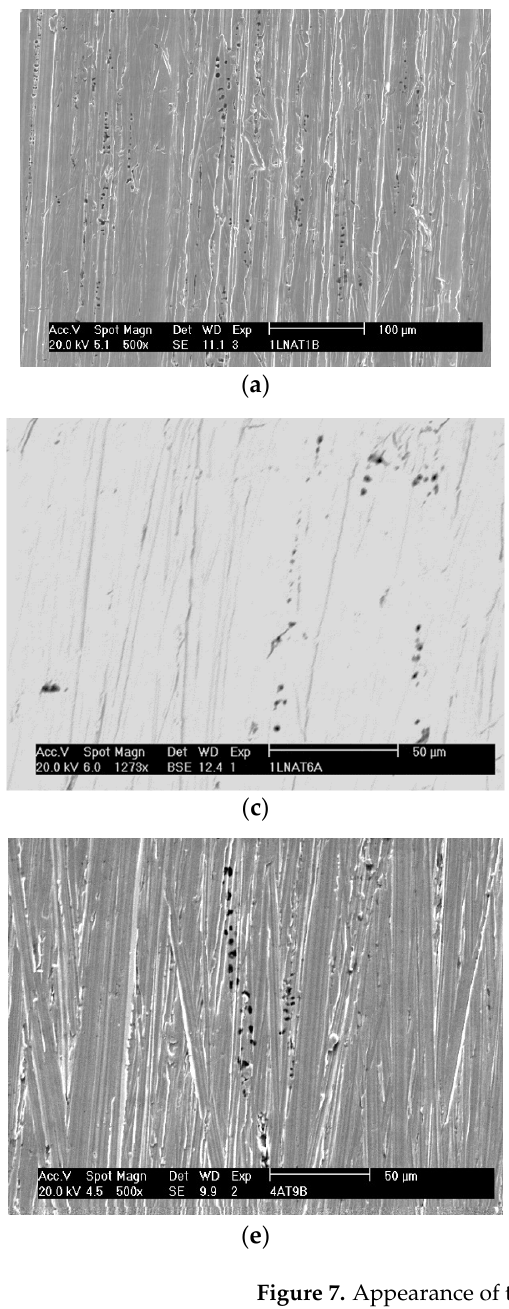
Figure 7. Appearance of the pits obtained by SEM after the corrosion test for the samples: A0 with secondary electrons at a magnification of ×500 ( a ), A1 with secondary electrons at a magnification of ×200 ( b ), A2 with backscattered electrons at a magnification of ×1273 ( c ), B0 with secondary electrons at a magnification of ×200 ( d ), B1 with secondary electrons at a magnification of ×500 ( e ), and B2 with secondary electrons at a magnification of ×500 ( f ).